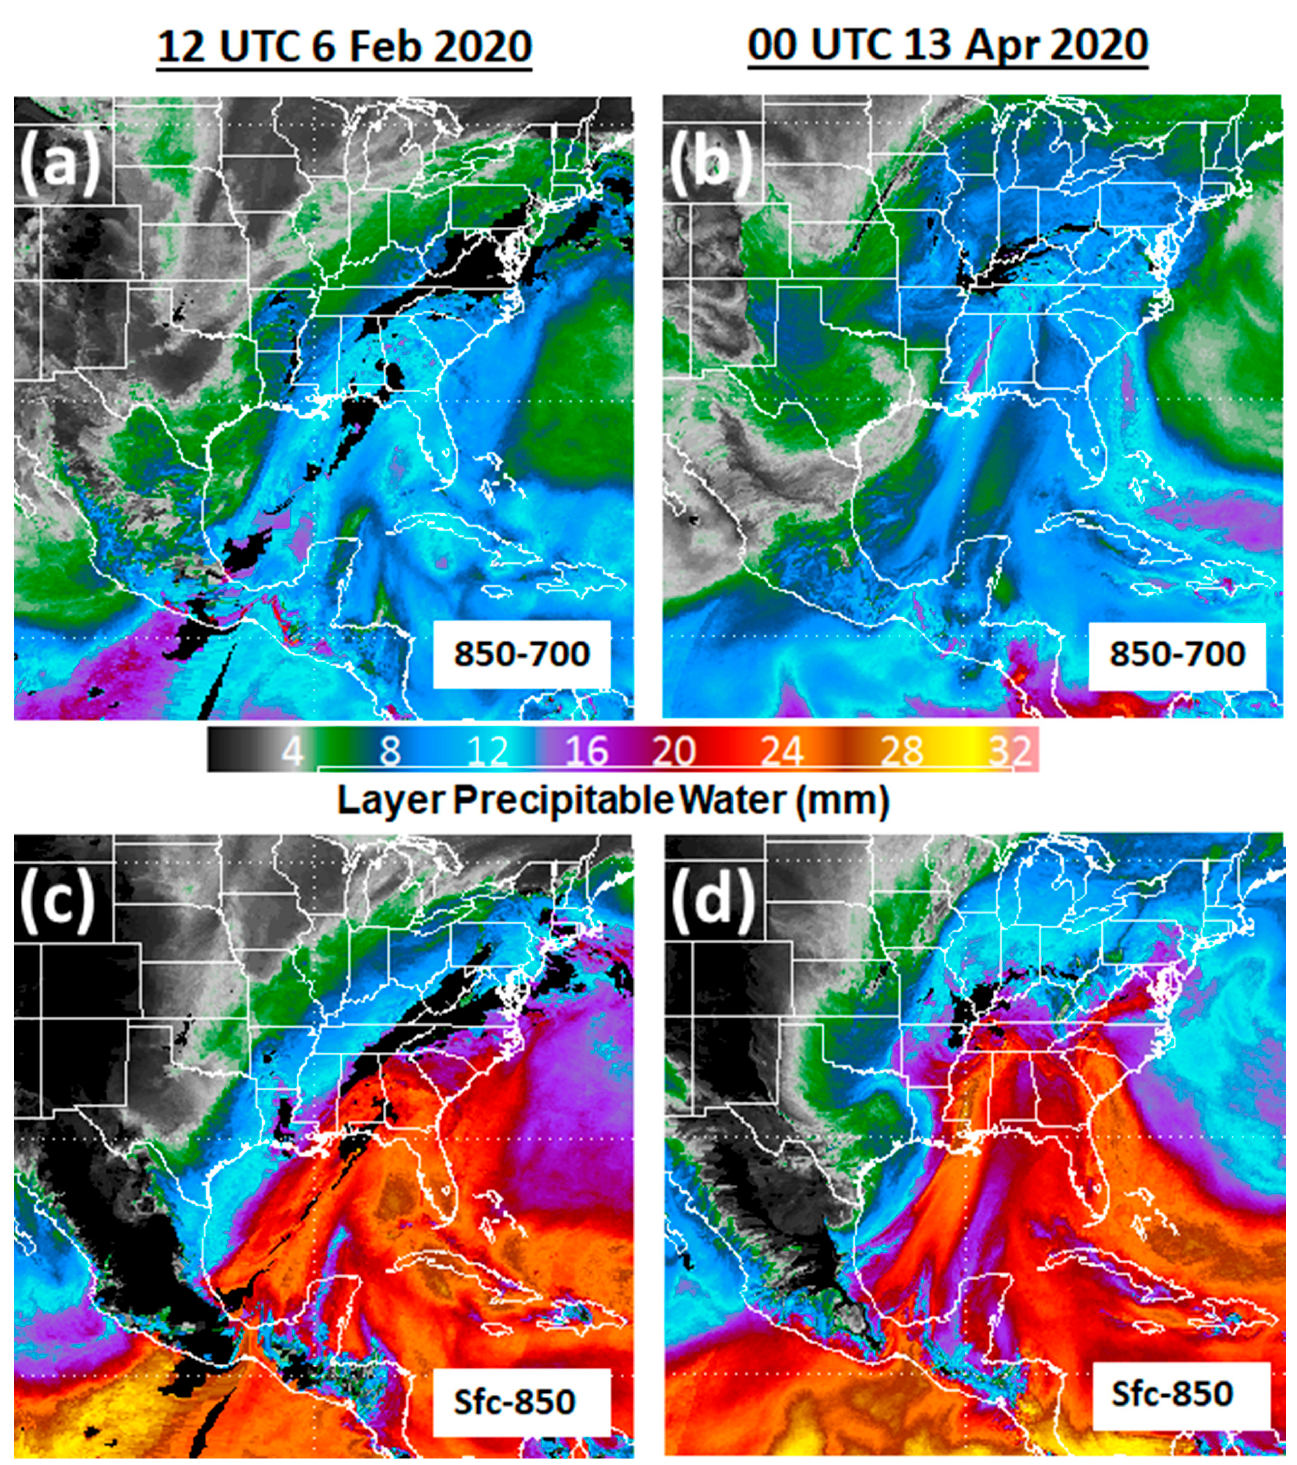
Figure 11. Advected Layer Precipitable Water (ALPW, mm) for the 850-700 hPa and surface-850 layers of the ( a ) and ( c ) February and ( b ) and ( d ) April 2020 case.